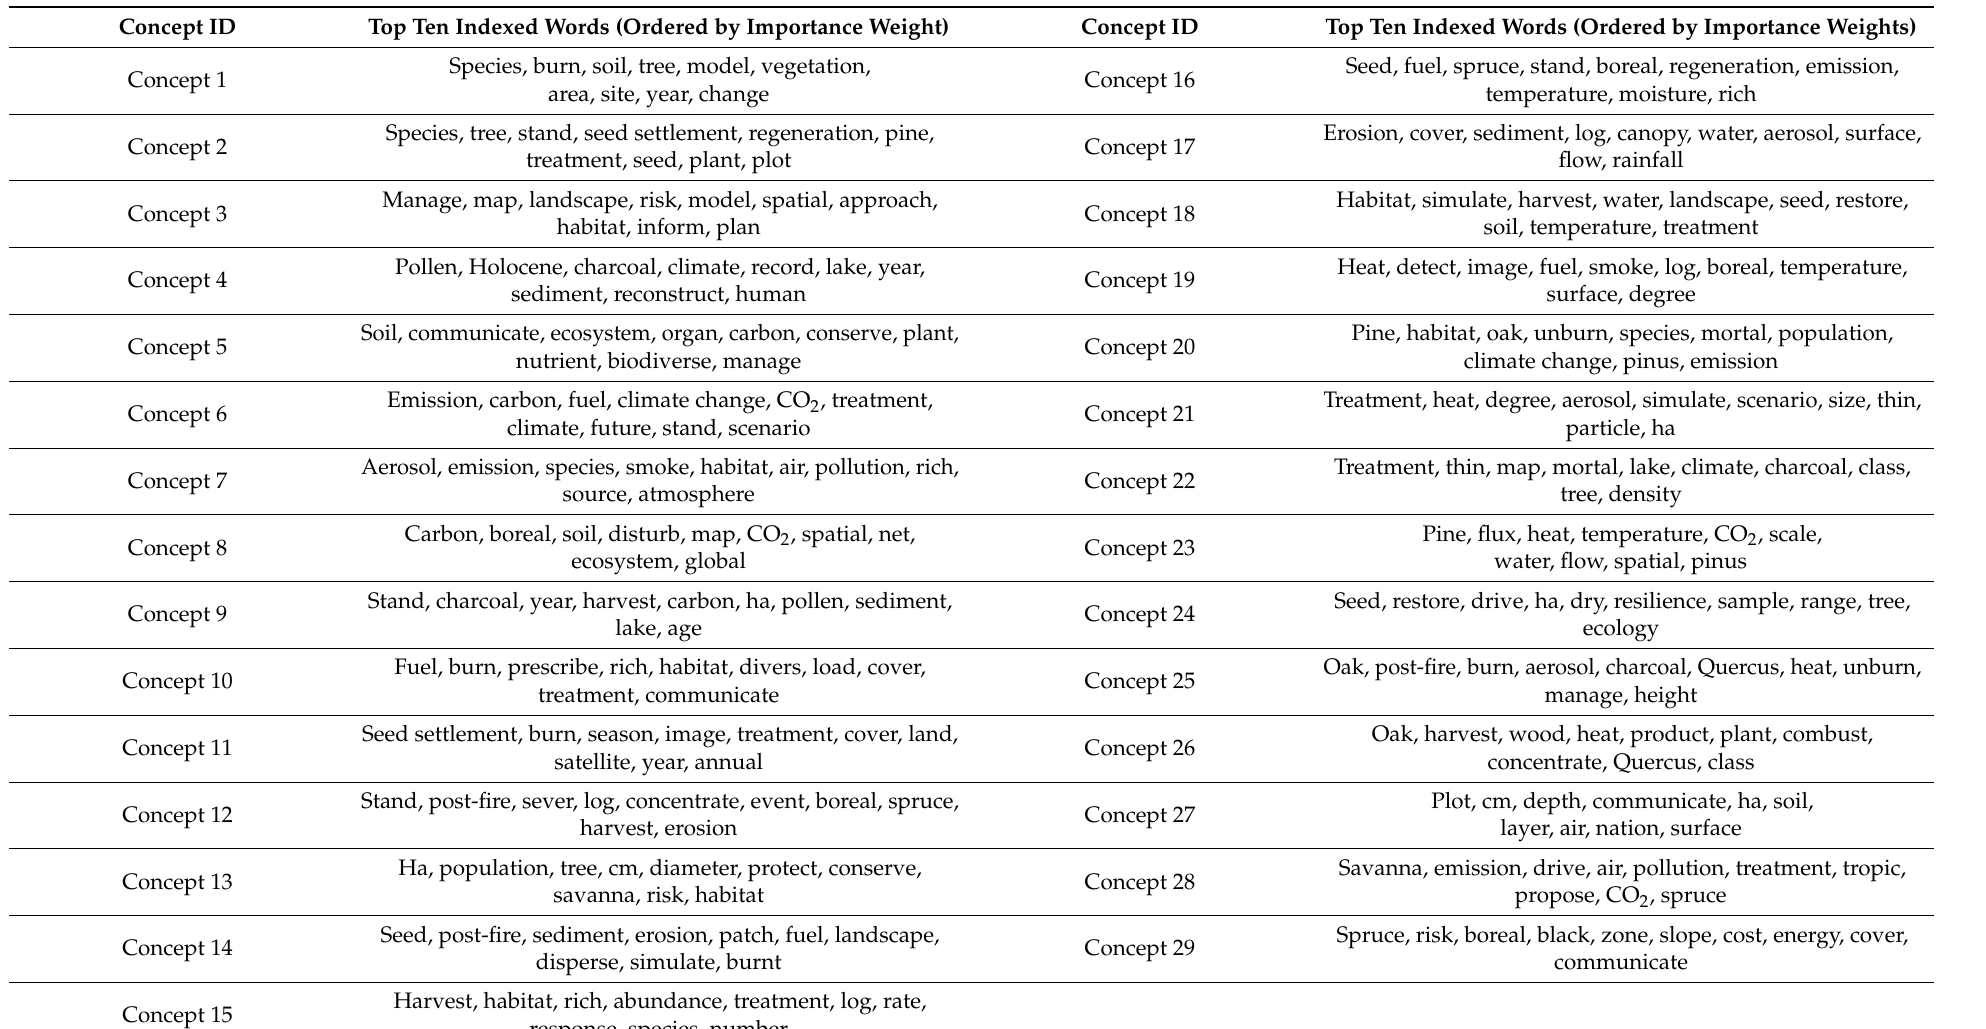
Table 8. Top ten indexed words via importance weights for each